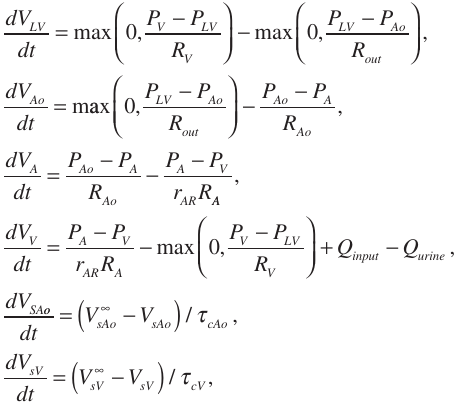
where C , C , and R are constants, and α A 0 V 0 A 0 stants that determine the magnitude of the effects of vasoconstriction